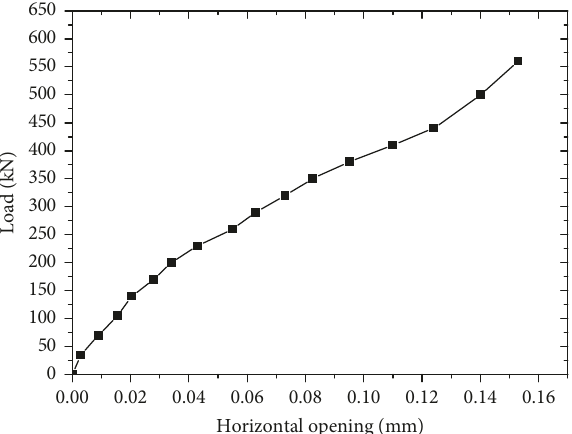
Figure 13: Load-horizontal opening curve at the hinge joint.